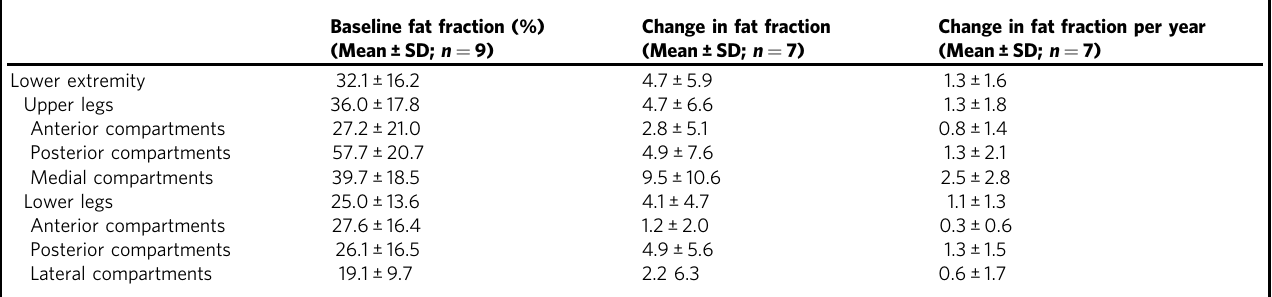
Fat fractions were calculated for individual musclesand subsequently averaged to calculate weighted composite scores for the lower extremity, upper leg, lower leg, and the muscle groups, both left and right leg averaged. Standard deviations for weighted composite scores in individual patients are not presented, as some muscle groups consisted of only one or two muscles. Upper leg: anterior compartment (rectus femoris, vastii muscles and sartorius), posterior compartment (biceps femoris, semitendinosus and semimembranosus), medial compartment (adductor magnus, adductor longus and gracilis). Lower leg: anterior compartment (tibialis anterior and extensor digitorum longus), posterior compartment (gastrocnemius, soleus, tibialis posterior, fl exor hallucis longus, fl exor digitorum longus and popliteus), lateral compartment (peroneus). Baseline fat fraction and change in fat fraction values of individual participants can be found in the supplemental Table